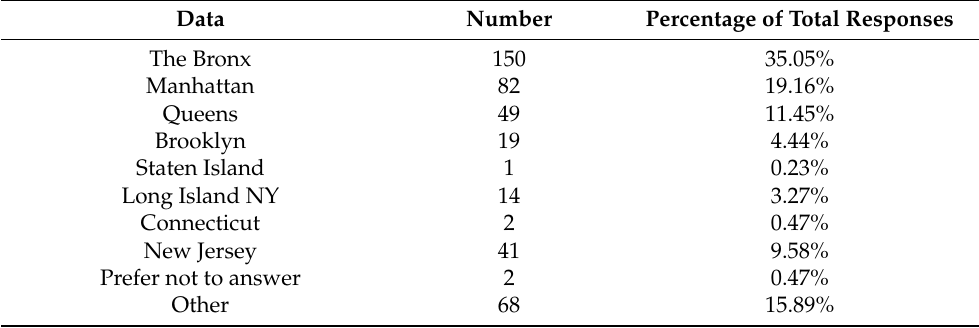
Table 1. Participant